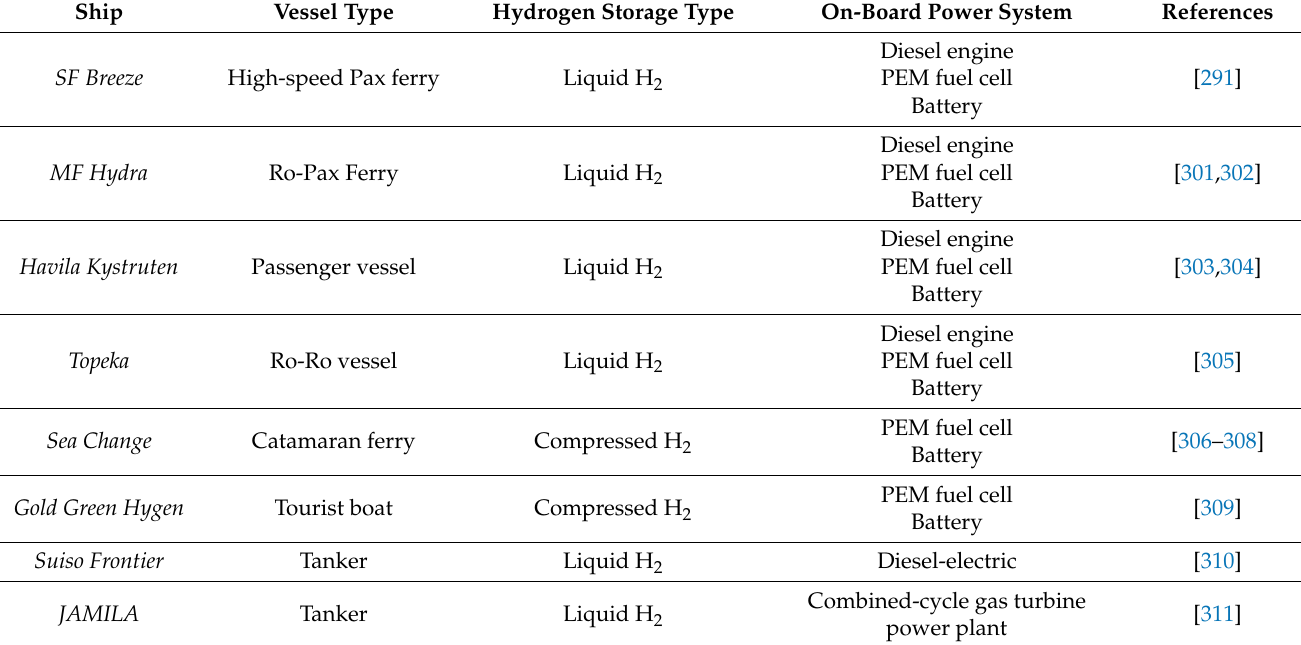
Table 6. Comparison of perspective energy carriers in marine transportation